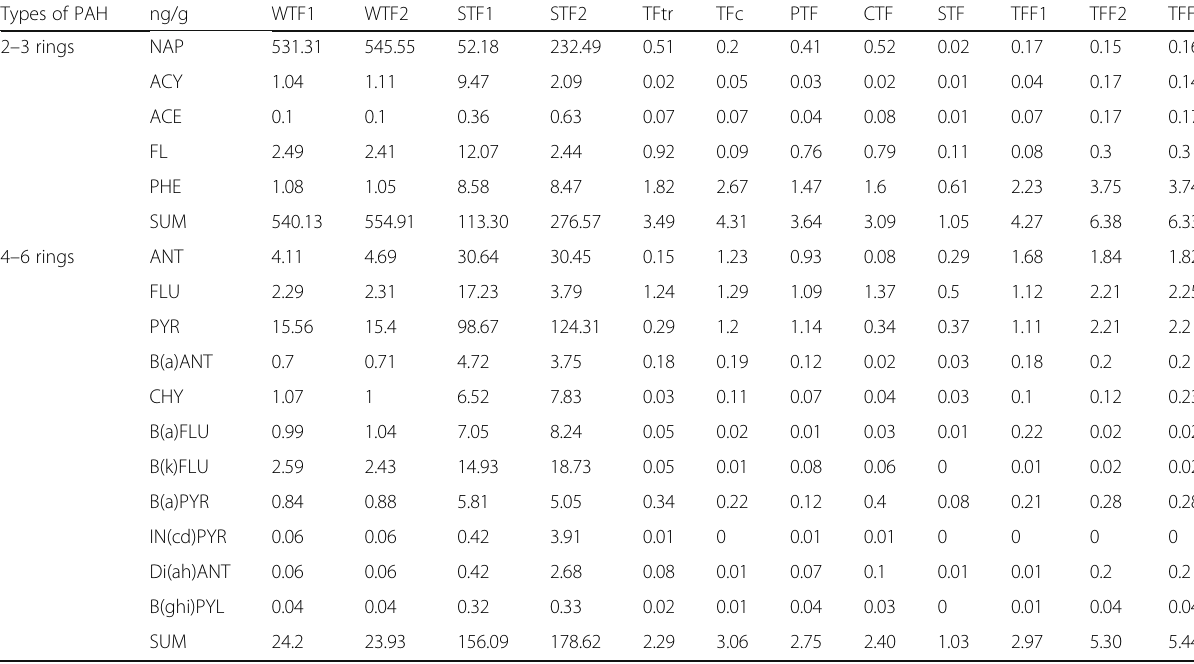
Table 3 Bioaccumulation of PAHs in water, sediment and selected aquatic organisms in Ibasa area of Lagos Lagoon Types of